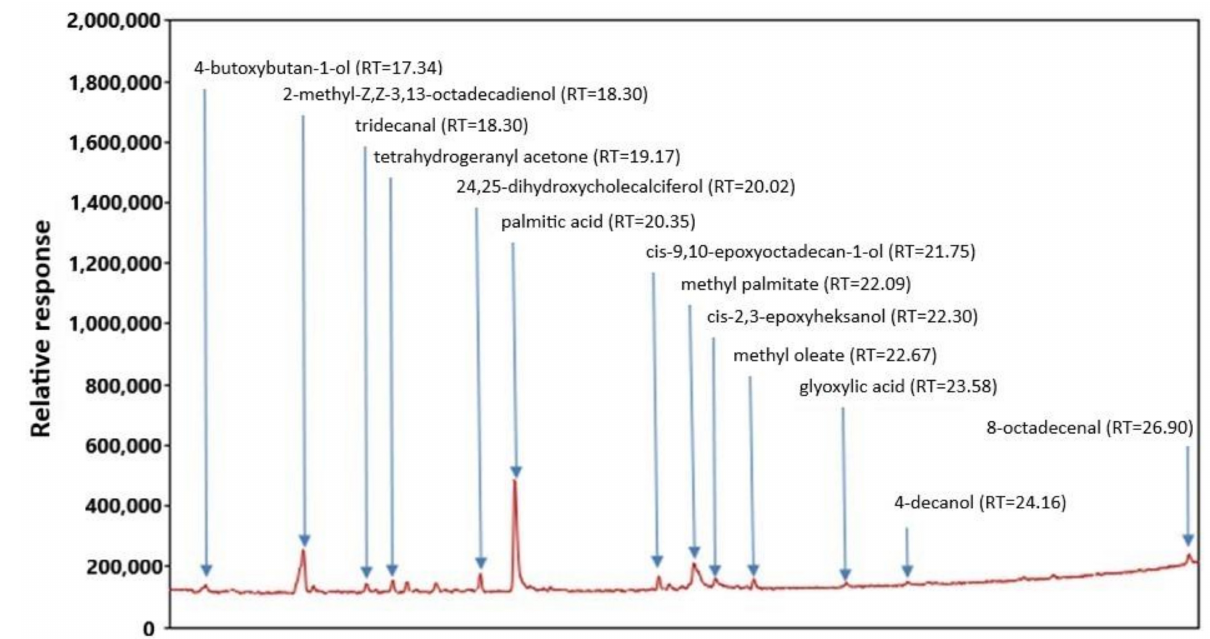
Figure 1. GC-MS chromatogram of FEE.